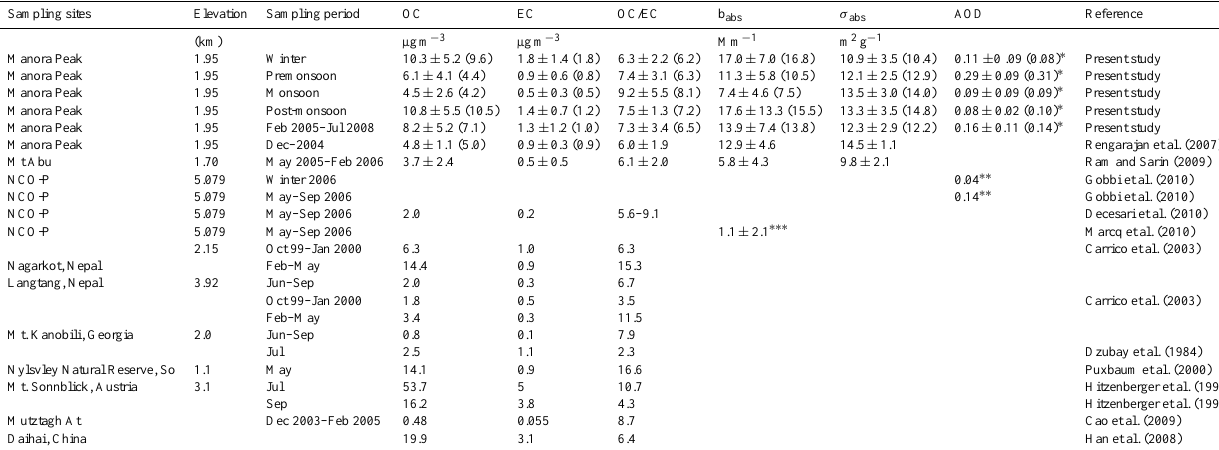
Table 2. Measured carbonaceous species and optical parameters (this study) and their inter-comparison with the reported data in the literature. Numbers in parenthesis represent median values.